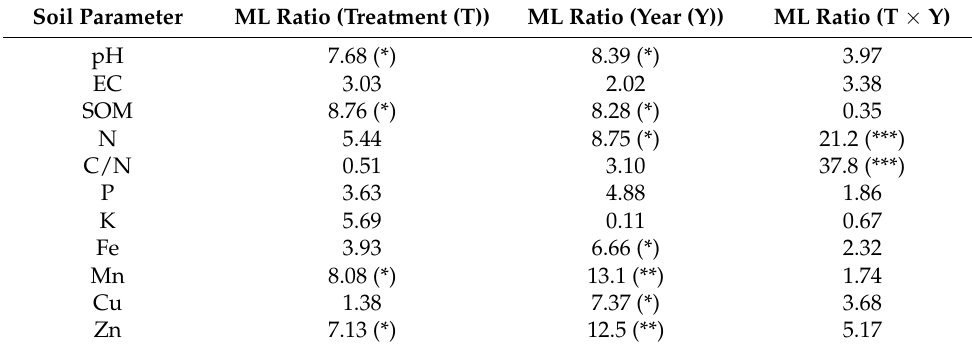
Table 1. Analysis of variance (ML: Maximum likelihood) performed on the soil parameters (pH, electrical conductivity (EC), soil organic matter (SOM), nitrogen (N), C/N ratio, phosphorus (P), potassium (K), iron (Fe), manganese (Mn), copper (Cu) and zinc (Zn)) at the leaf fall stage. The results were significant at * p < 0.05, ** p < 0.01 and *** p < 0.01.